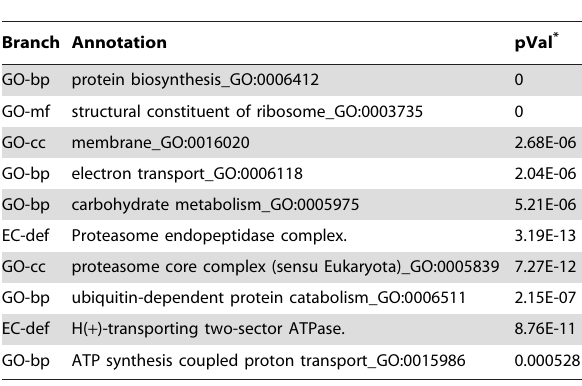
Table 1. Enriched Annotations in